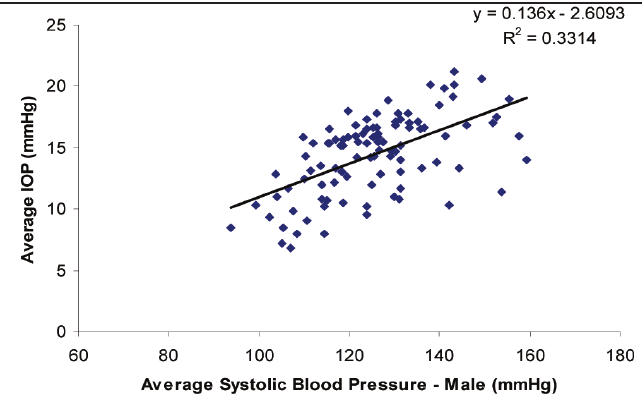
Figure 5: Relationship between average IOP and average systo- lic BP in males.